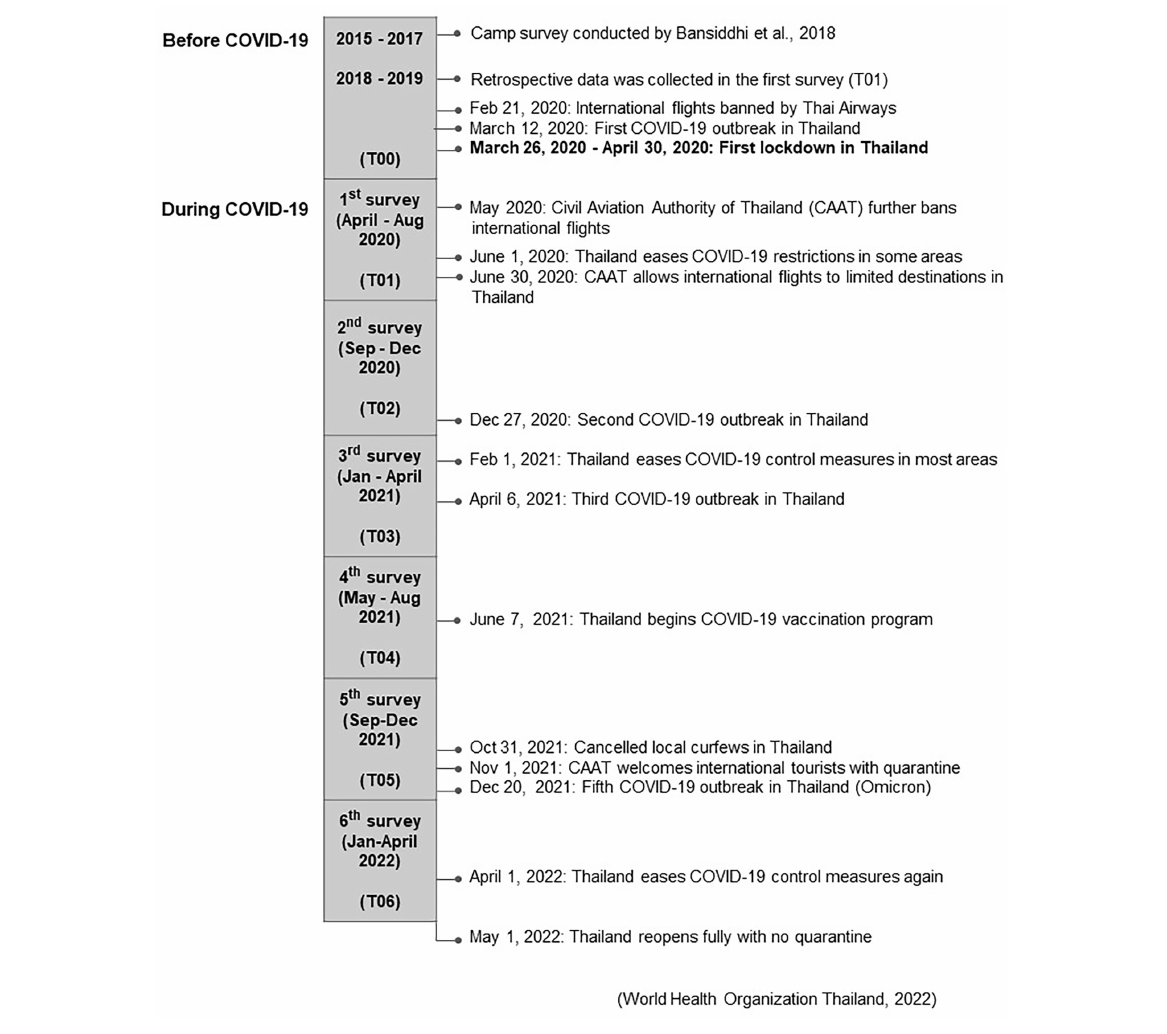
during the study is shown in Figure 2. Thailand did not fully open to international travelers with no restrictions until 1 month after the last